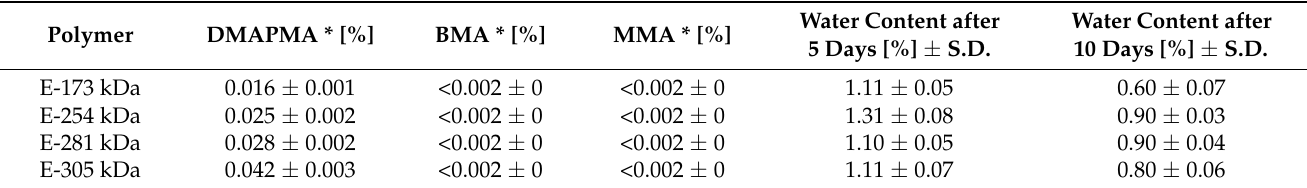
Table 2. Residual monomer and water content after purification and drying of ModE. Each value designates the mean ± S.D. (n = 3).